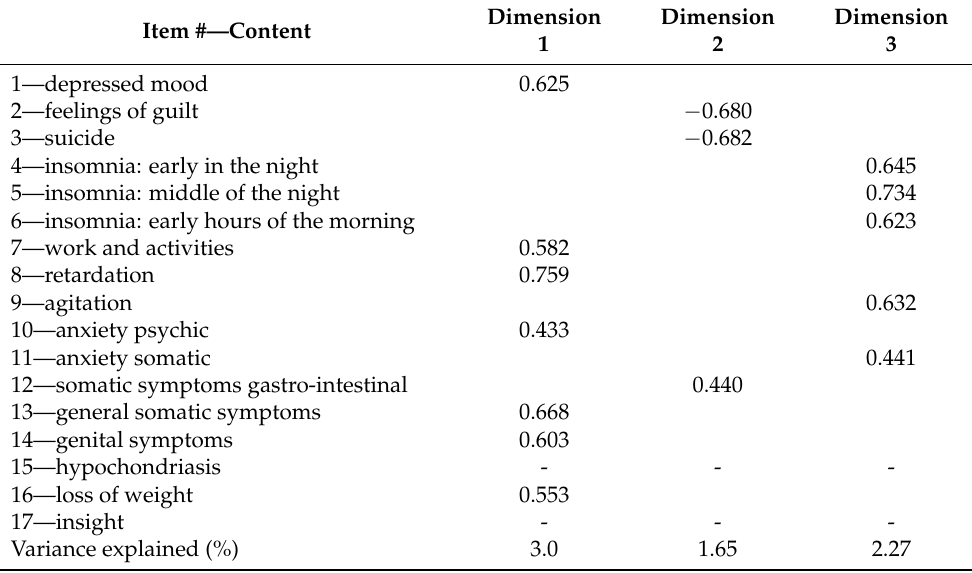
Table 3. Hamilton Depression Rating Scale (HDRS-17) principal component analysis.